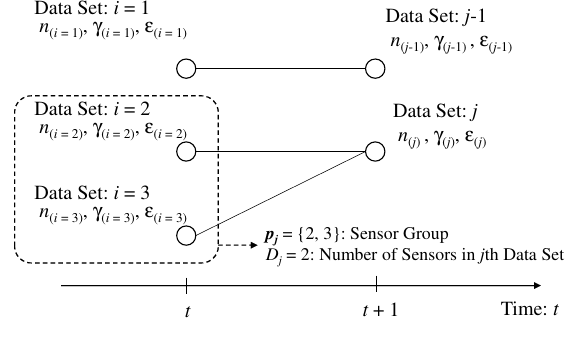
Figure 4. Example of labeling problem for data separation with the duplication of sensing